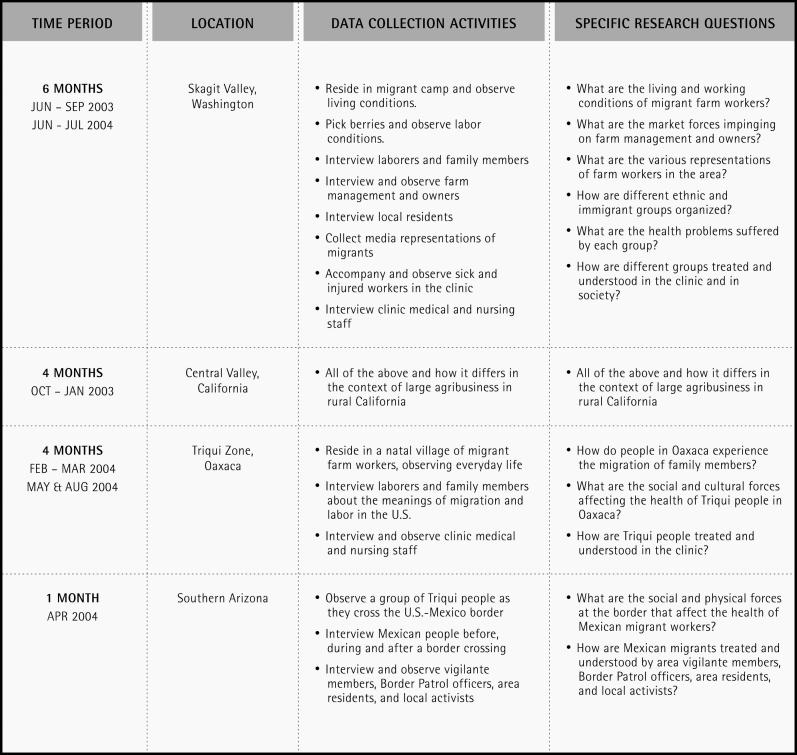
Summary of Field Work